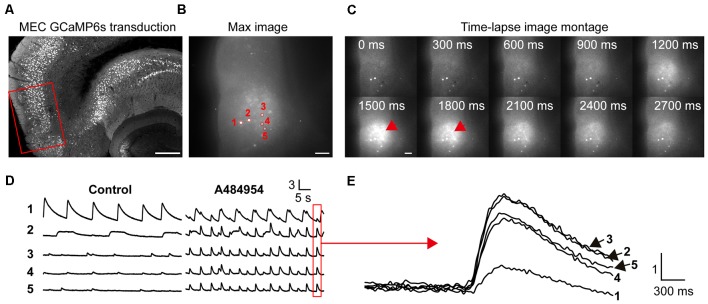
A484954 evoked an increase of cross-correlation in the medial entorhinal cortex (MEC). (A) A section of an entorhinal–hippocampal slice that was transduced with GCaMP6s in the MEC is shown. The red rectangle indicates a representative position of the time-lapse fluorescence acquisitions. Horizontal scale bar = 300 μm. (B) A representative fluorescence image of the MEC region in a 300-μm-thick acute slice and five ROIs have been presented. Horizontal scale bar = 100 μm. (C) A sequence of images of a time-lapse acquisition is shown in a montage. Red arrows indicate increased fluorescence after A484954 application. Scale bar = 100 μm. (D) The fluorescence traces for five representative ROIs shown in (B) are depicted. Under control condition, only one area of the MEC oscillated, whereas the other four areas showed random activities. After application of A484954, the activity within different ROIs enhanced in a synchronized manner. (E) The traces in the red box in (D) were overlaid and presented at higher temporal resolution. Vertical scale bar: ΔF/F0.